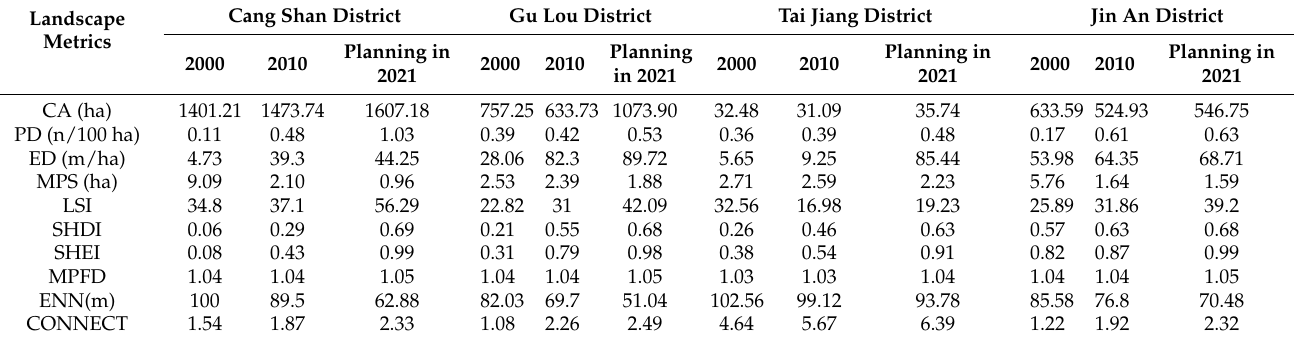
Table 5. Landscape metrics on landscape level of Cang Shan, Gu Lou, Tai Jiang, and Jin An district. Landscape